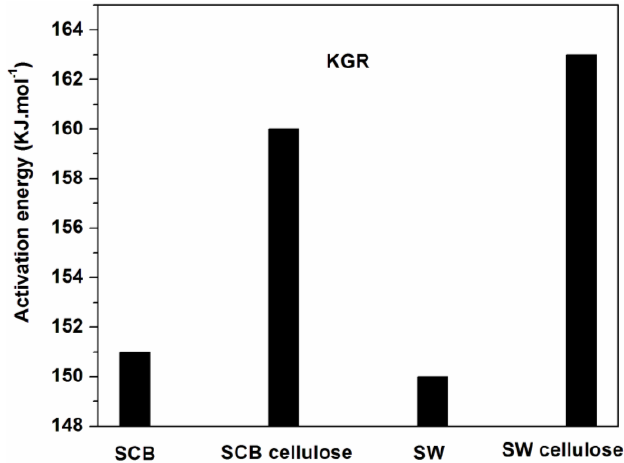
Figure 8. Activation energy values as a function of degrees of conversion obtained by KGR.